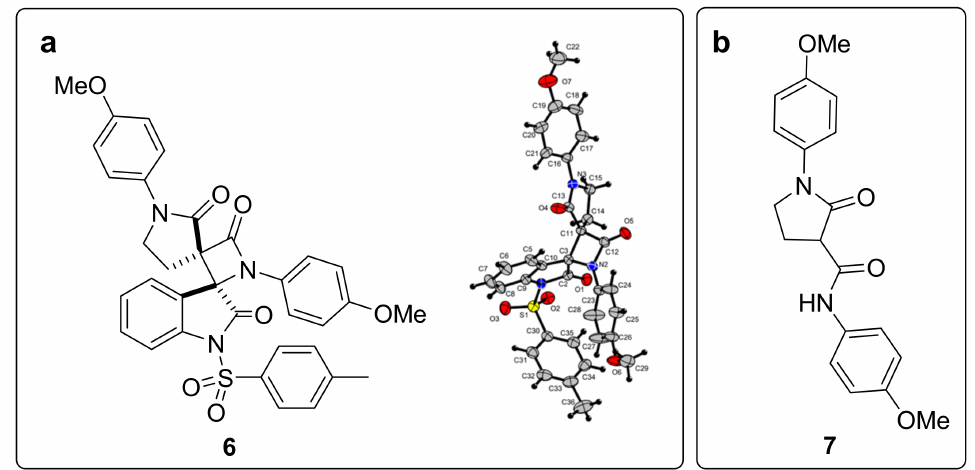
Figure 5. By-products of compound 5a synthesis: ( a ) p -toluene sulfonylamide 6 ; ( b ) N,1-bis(4- methoxyphenyl)-2-oxopyrrolidine-3-carboxamide 7